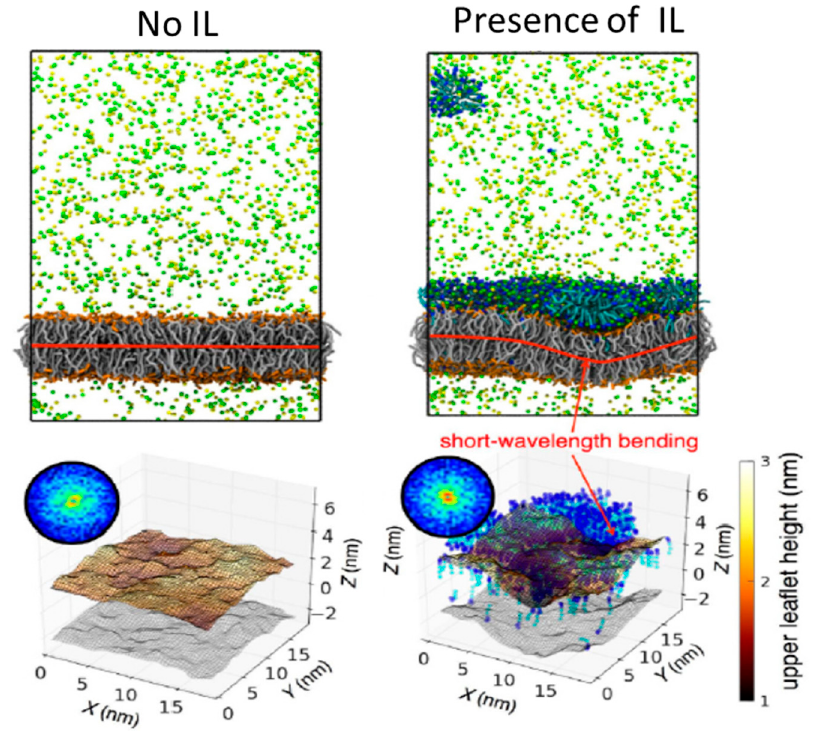
Figure 16. Upper row: snapshots of coarse-grained simulations of the capacity of ILs to induce bending of a 1-palmitoyl-2-oleoyl-sn-glycero-3-phosphocholine (POPC) bilayer lipid system with and without the IL, in this case 1-decyl-3-methylimidazolium chloride [DMIM][Cl]. Bottom view: Plotting of the 3-D contour surface of the upper leaflet height based on the phosphate group of the POPC. The bilayer center of the mass plane is shown in red to guide the eye. The lower leaflet surface is shown in gray. Spectral intensity based on the Fourier Intensity peaks corresponding to the bright red regions is associated with high amplitude bending modes of the bilayer surface. Adapted from [180].